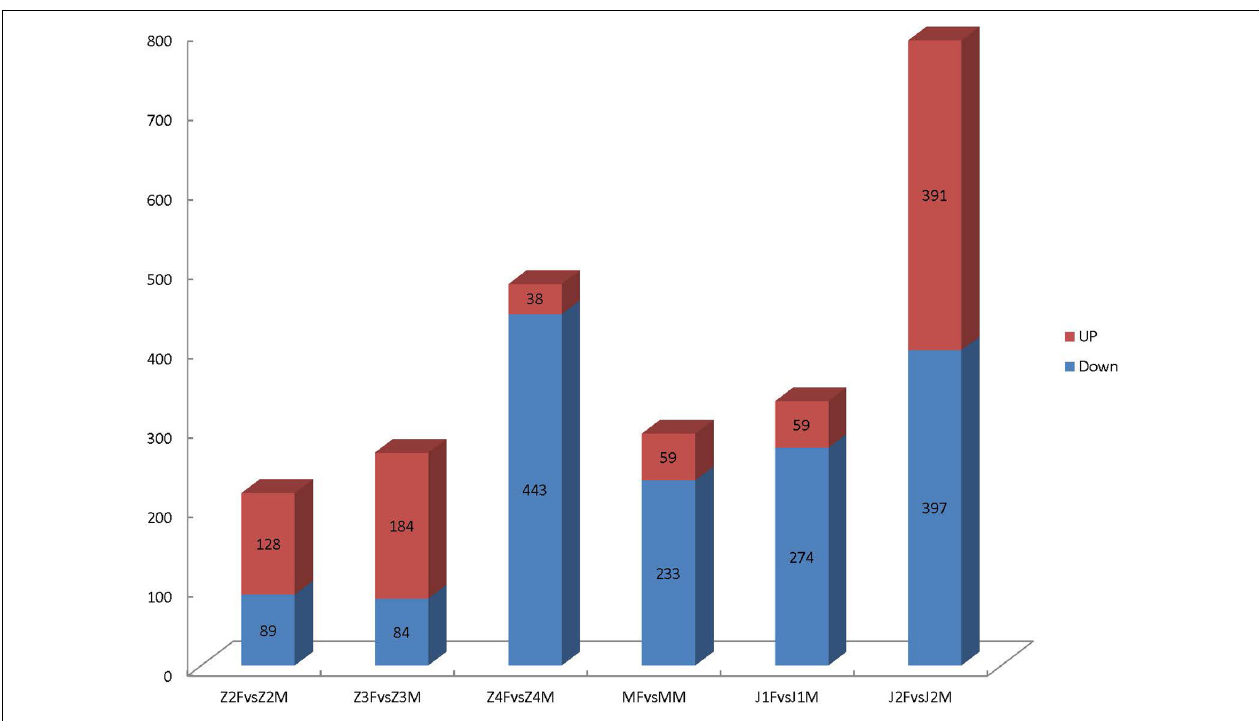
FIGURE 2 | Differential gene transcription analyses in the early stages of growth.